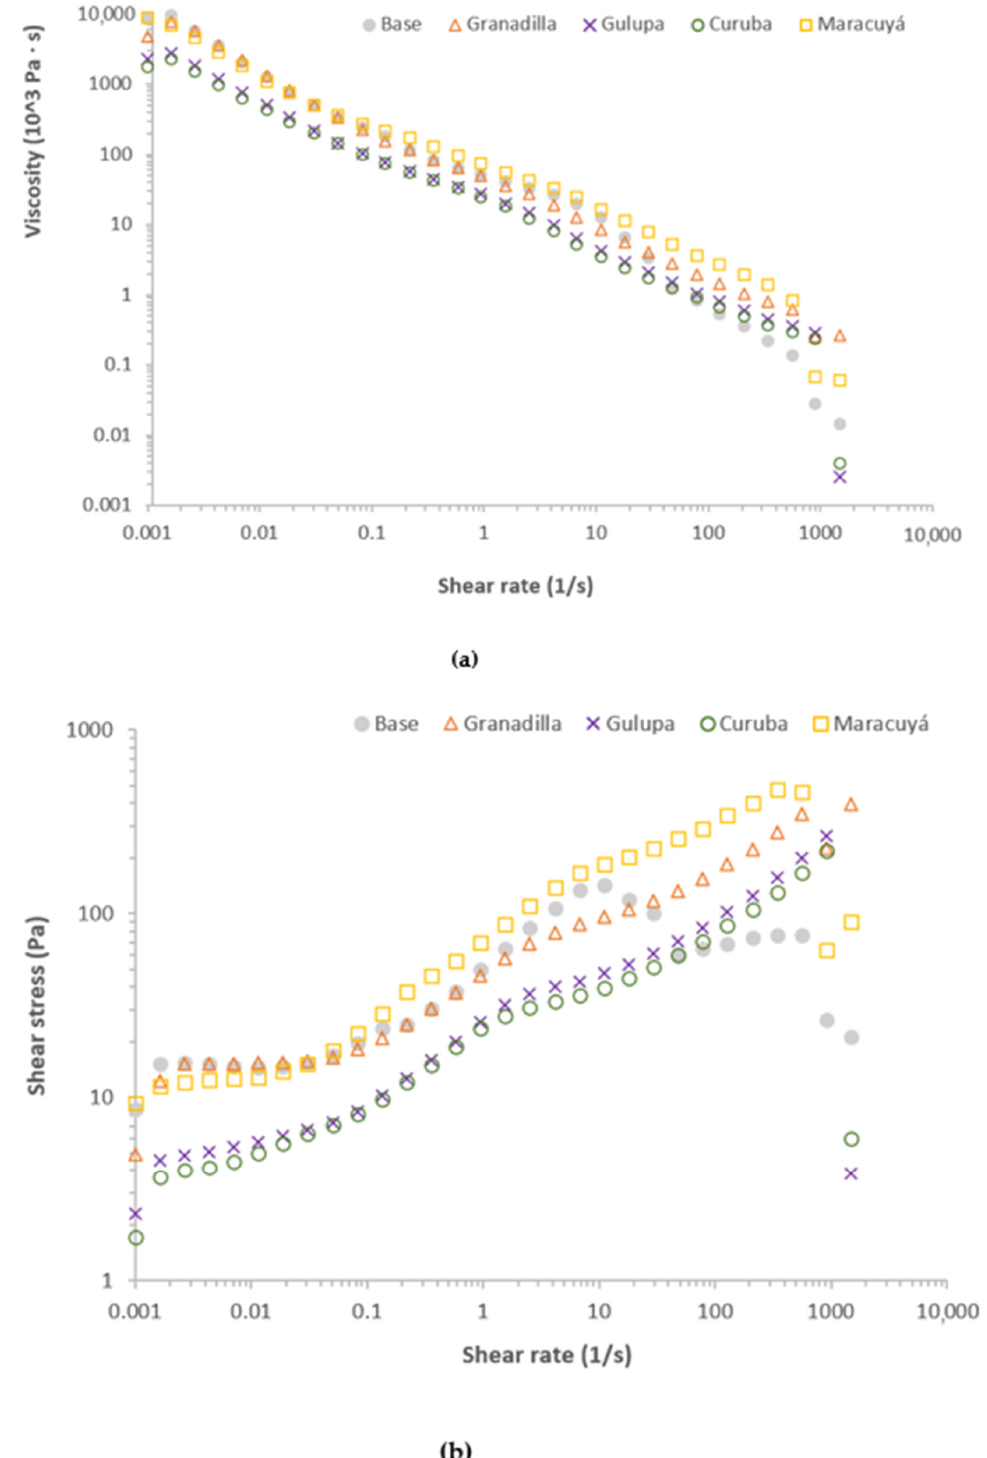
Figure 7. ( a ) Viscosity and ( b ) shear strength profiles of exfoliant prototypes after thermal shock. “Granadilla” ( Passiflora ligularis ), “gulupa” ( P. edulis Sims fo edulis ), “curuba” ( P. mollissima ), and “maracuy á ” ( P. edulis ,